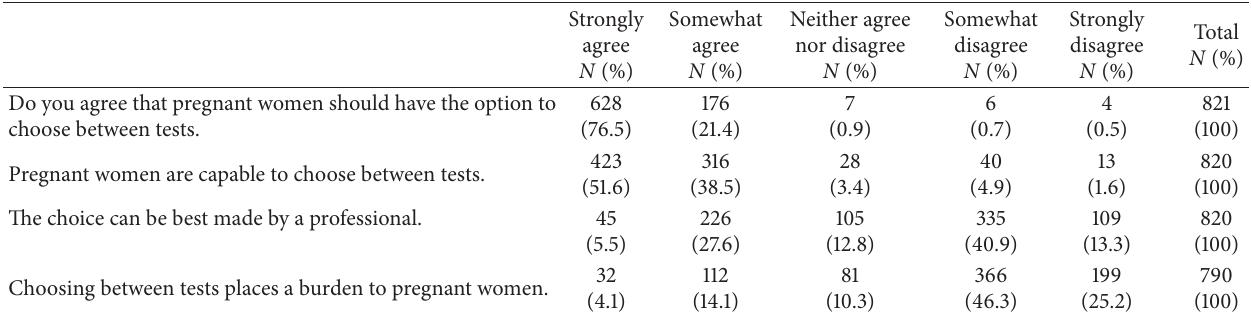
Table 2: Data about the general attitude of women about having the option to choose between prenatal tests.